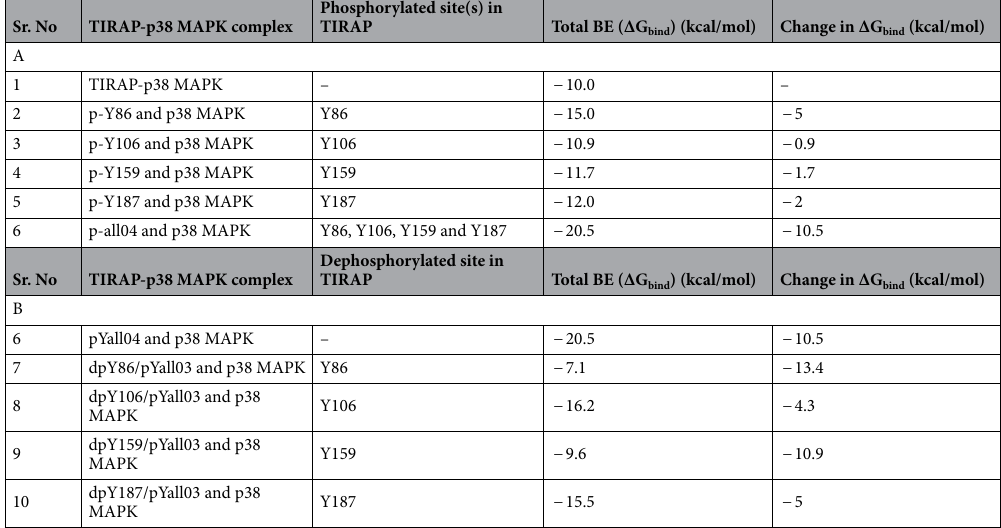
Table 2. The energetic effect of phosphorylation and dephosphorylation of tyrosine residues (Y86, Y106, Y159, and Y187) in the TIR domain of TIRAP were calculated in terms of change in the free binding energy (BE) of TIRAP and p38 MAPK complexes. (A) Phosphorylation of tyrosine residues significantly decreases the binding energy (∆G bind ) of TIRAP and p38 MAPK complex, with the highest decrease seen with pY86 while the modest seen with pY106 (B) the sequential dephosphorylation shows the highest destabilizing effect occurs with dephosphorylation of Y86 and Y159 while the modest with